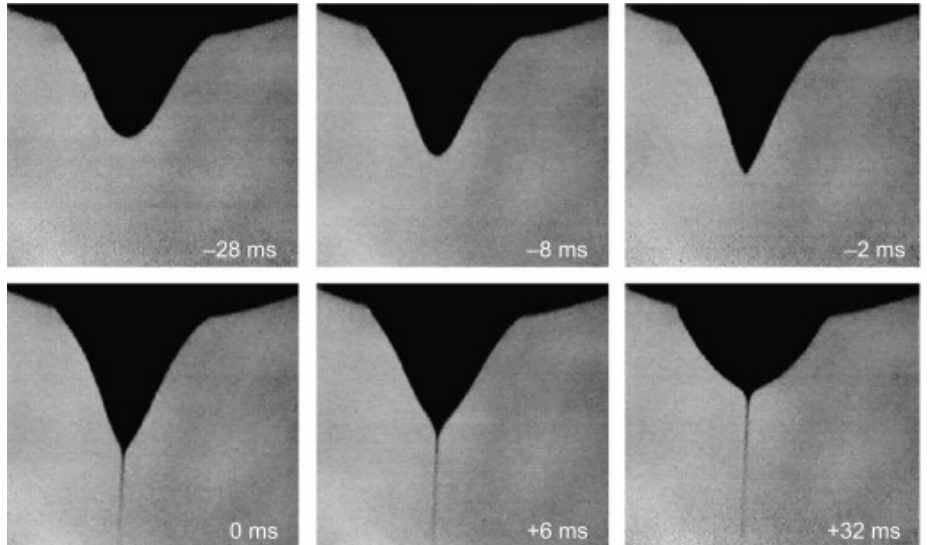
Figure 3. Droplet deformation of polyethylene oxide solution captured at − 28 ms, − 8 ms, − 2 ms, 0 ms, +6 ms, and +32 ms time-frames; the constant voltage was applied approximately 28 milliseconds before the cone–jet initiation (at − 28 ms); cone–jet (Taylor cone) started at 0 ms onwards, culminating in the formation of the jet in the electrospinning process. Reprinted from ref.